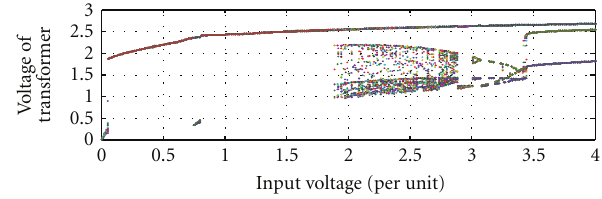
Figure 6: Bifurcation diagram with q = 7 (ZnO e ff ect).